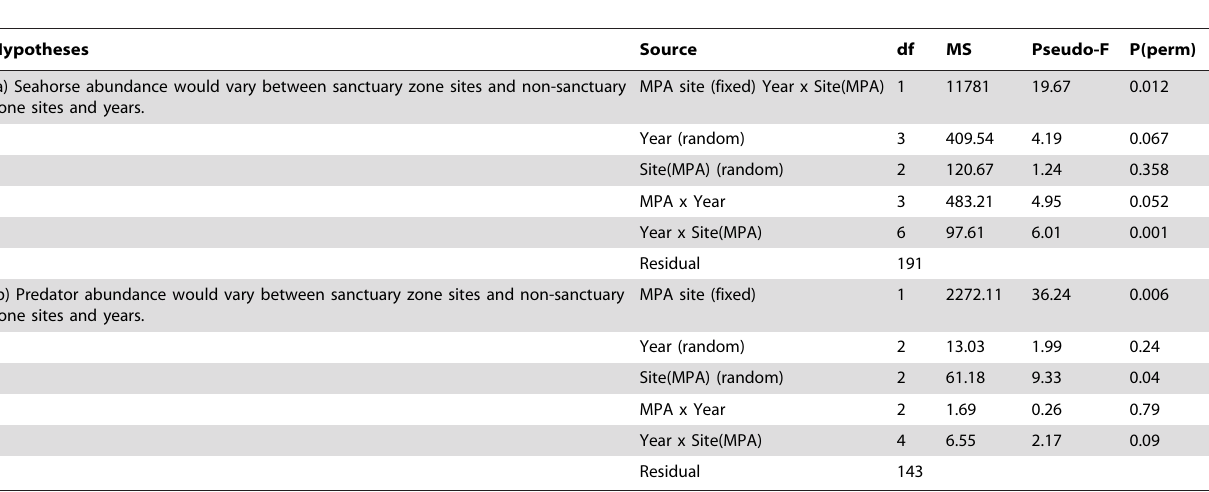
Table 1. Summary of hypotheses tested in the long term monitoring of H. whitei and predator abundance within and outside a marine protected area (MPA) with details of statistical analysis performed and PERMANOVA results.